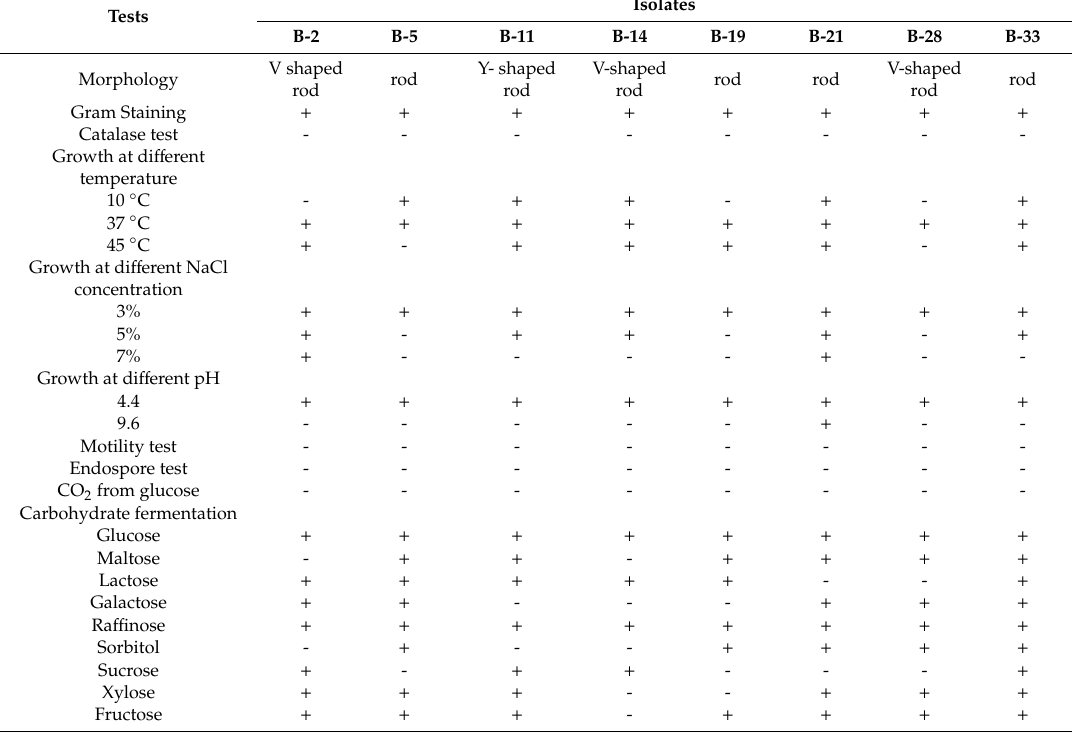
Table 1. Morphological, physiological and biochemical characterization of the